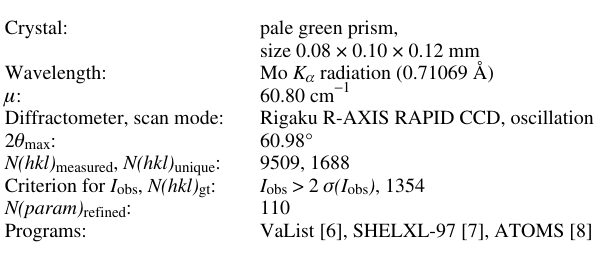
Table 1. Data collection and